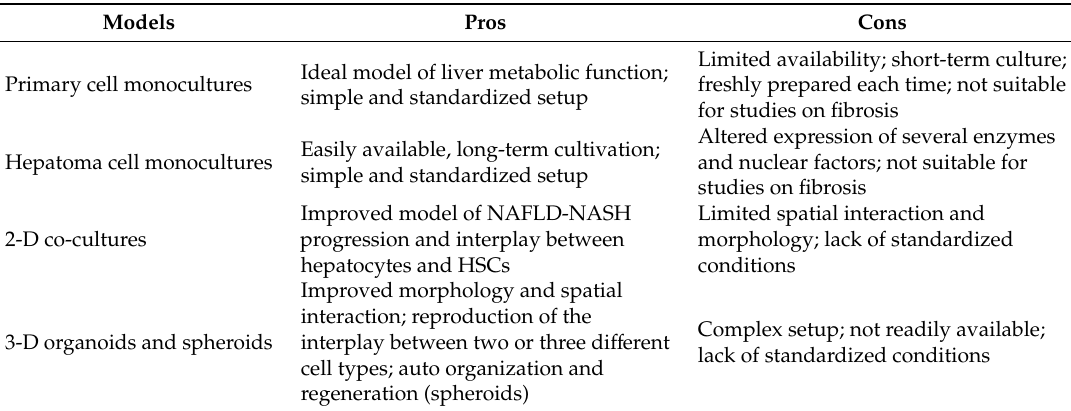
Table 3. In vitro experimental models for the study of NAFLD and